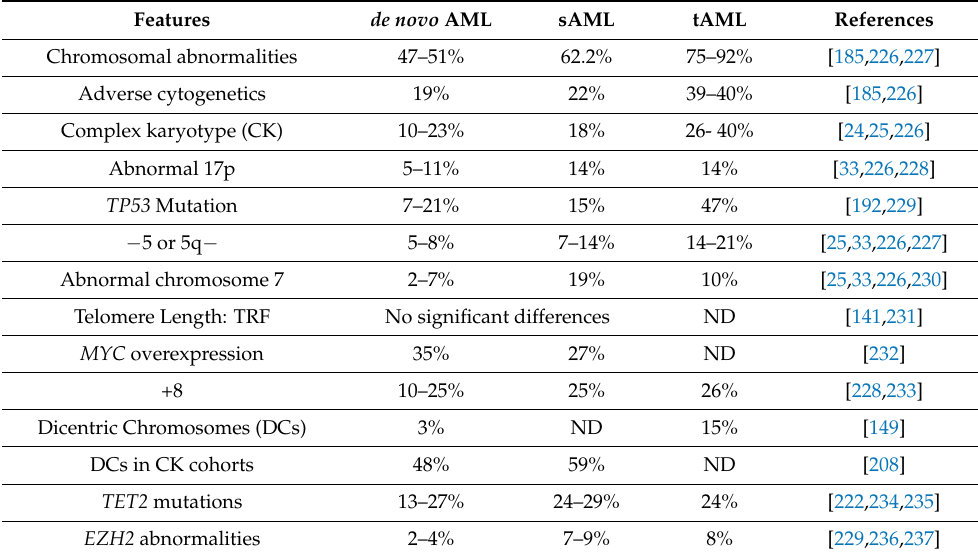
Table 2. Incidence of CIN features in different types of